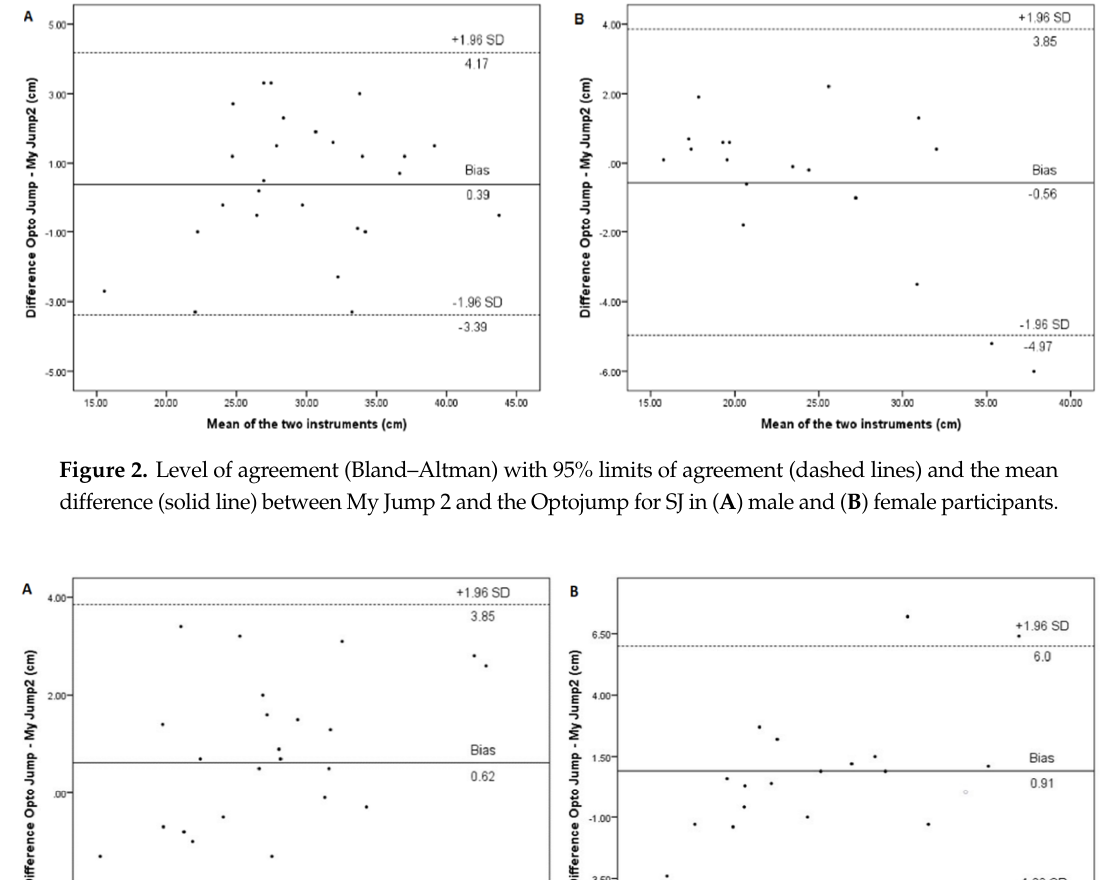
Figure 3. Level of agreement (Bland–Altman) with 95% limits of agreement (dashed lines) and the mean difference (solid line) between My Jump 2 and the Optojump for CMJ in ( A ) male and ( B ) female participants. Appl. Sci. 2020 , 10 , x FOR PEER REVIEW